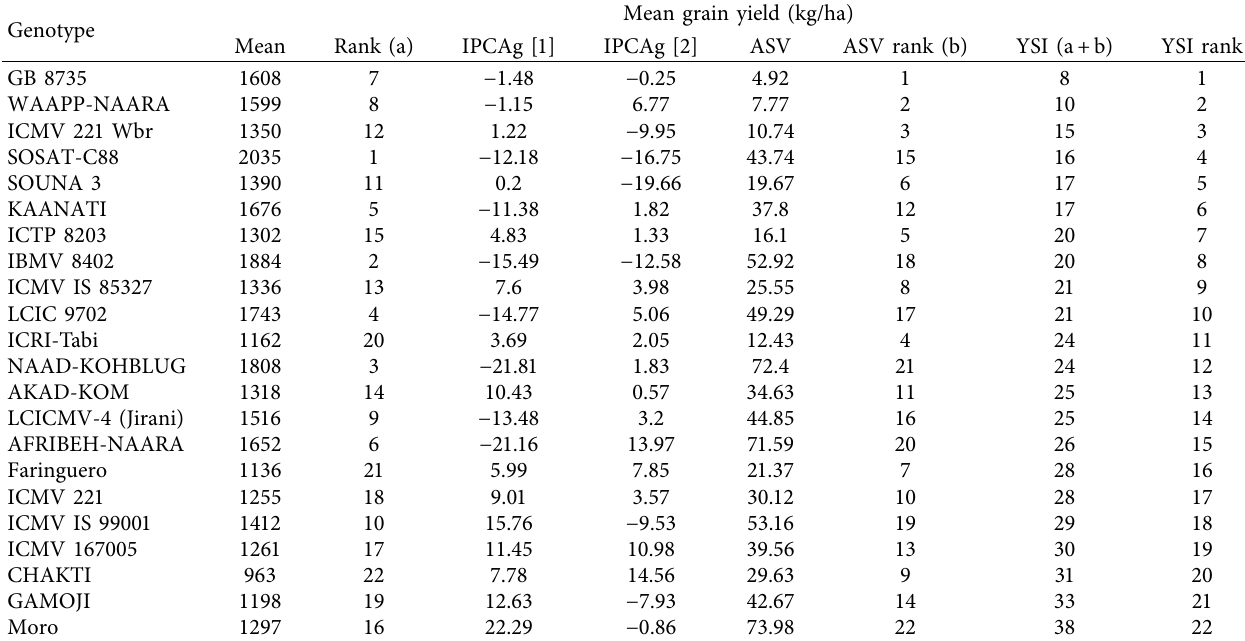
Table 8: Mean grain yield, AMMI stability values (ASV), and yield stability index (YSI) rankings of 22 OPV pearl millet genotypes pooled across two locations and three seasons in Ghana.